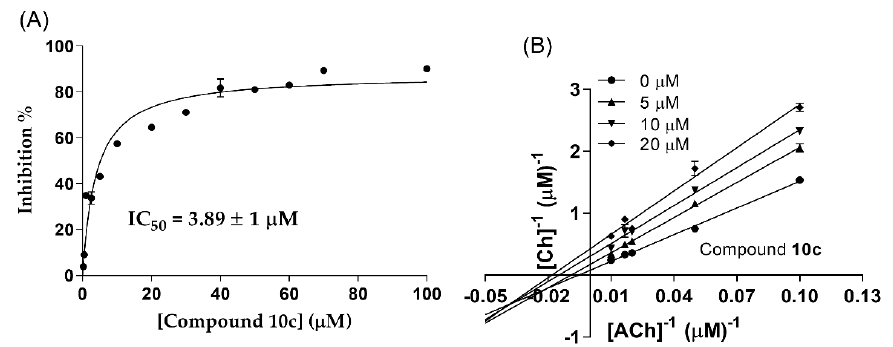
Figure 2. Dose-response inhibition curve ( A ) and Lineweaver − Burk reciprocal plots ( B ) for com- pound 10c BChE hu -ICER using the on-flow dual parallel enzyme assay. Results obtained from three independent experiments (n = 3) expressed by mean ± SEM.